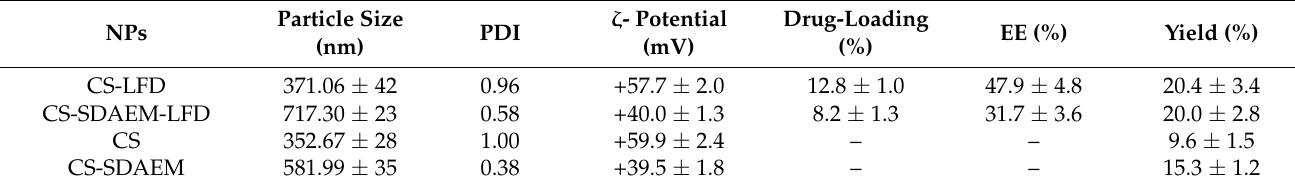
Table 1. NP’s DLS size and ζ -potential, as well as drug-loading, EE, and